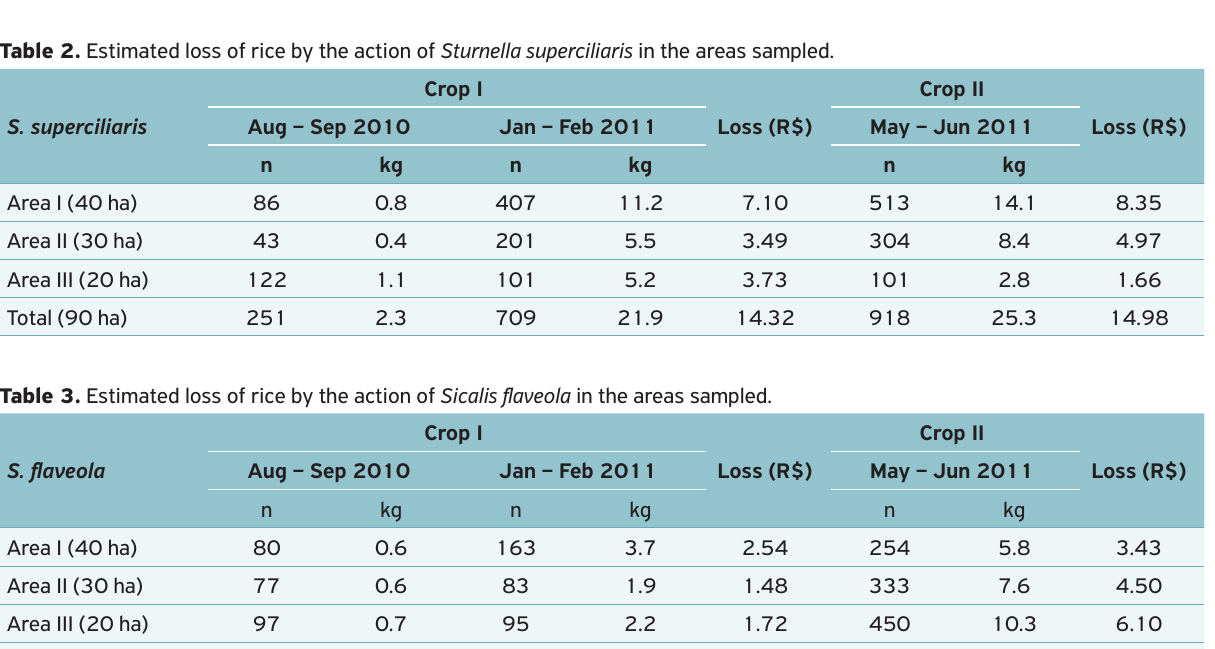
Table 2. Estimated loss of rice by the action of Sturnella superciliaris in the areas sampled.